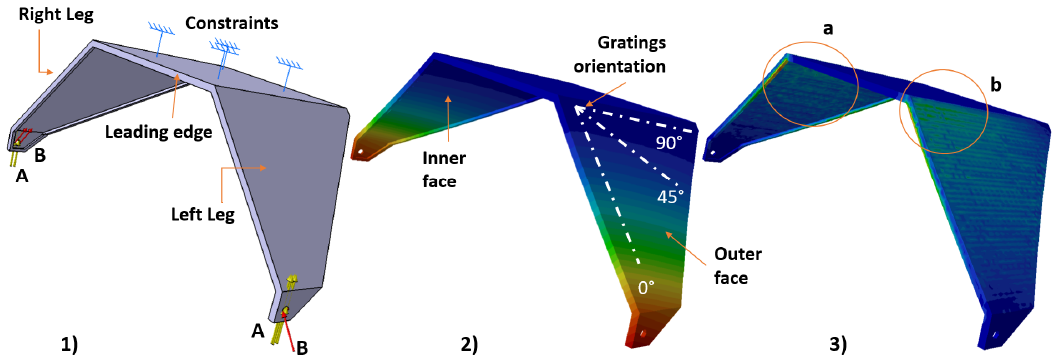
Figure 7. ( 1 ) Preliminary static analysis of a simplified model of the landing gear. FEM model configuration: Constraints, the TA is attached to the impactor through the interface plate. Loads: (A) Upward-directed constraint reaction (action of TA + impactor weight on wheel hinges, shown in yellow), and (B) Constraint reaction of the leaf springs (shown in red). ( 2 ) Displacements resulting from preliminary finite element analysis. The color scale identifies the areas that are most deformed (greatest value of displacement) by indicating them in red. In blue are the areas experiencing the least displacement. ( 3 ) The Main Stress Tensor (nodal values, N/m 2 ) shows the areas of the inner face (a) and outer face (b) that are most stressed and correspond to the areas on which the gratings were installed.